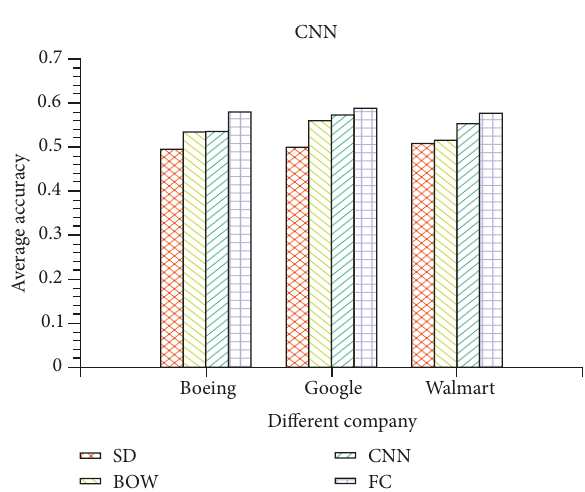
Figure7:AverageaccuracyachievedonthebasisofnewsfromCNN and different feature